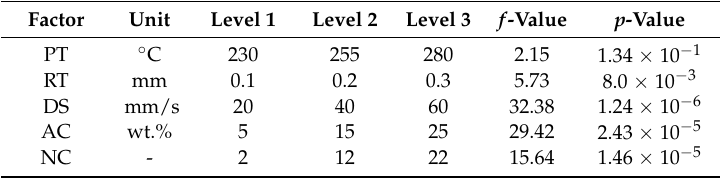
Table 6. ANOVA results for ULSF for aluminum 2024-T3/ABS hybrid